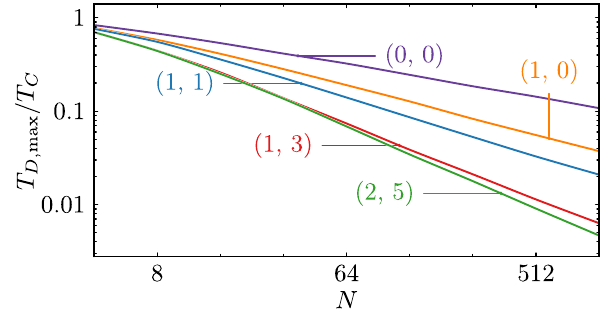
=T FIG. 12. Largest fraction T of dead time compared to D; max C cycle time for which the clock operation is limited predominantly by the variationally optimized instability displayed in Fig. 11. The overall instabilities at dead time fractions above the lines are limited by the Dick effect